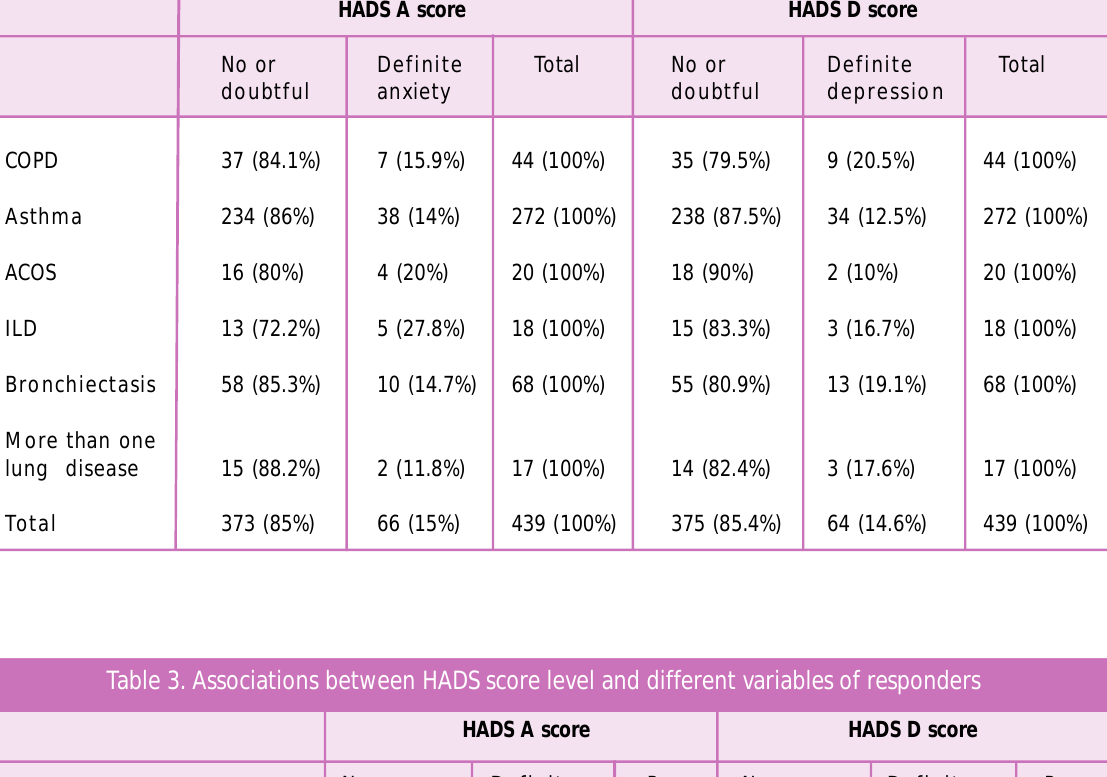
Table 2. Distribution of HADS scores for anxiety and depression against the type of lung disease HADS A score